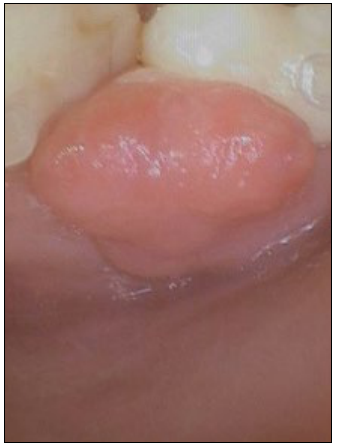
Figure 1a. Well-circumscribed firm mass at the interdental papilla between the first and second mandibular molars.